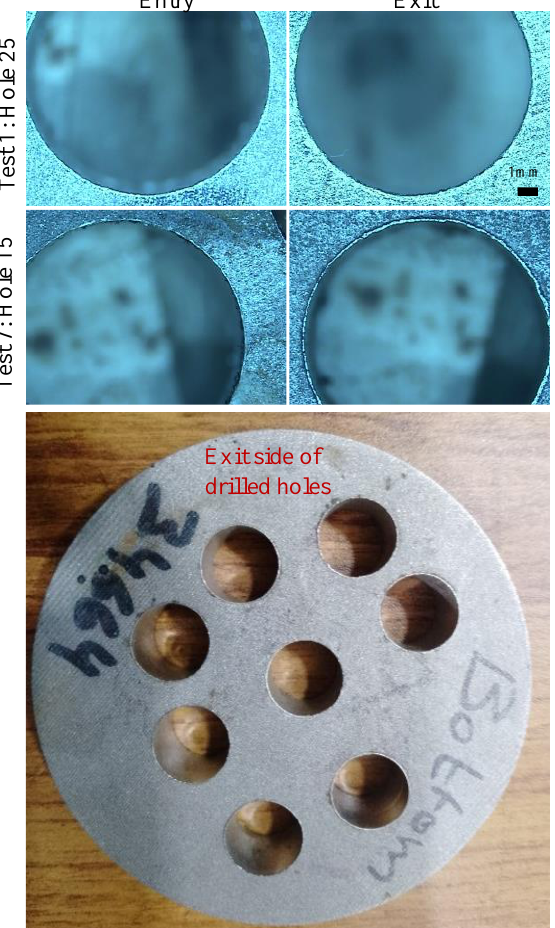
Figure 21. Images of drilled holes on entry and exit sides for various tests.